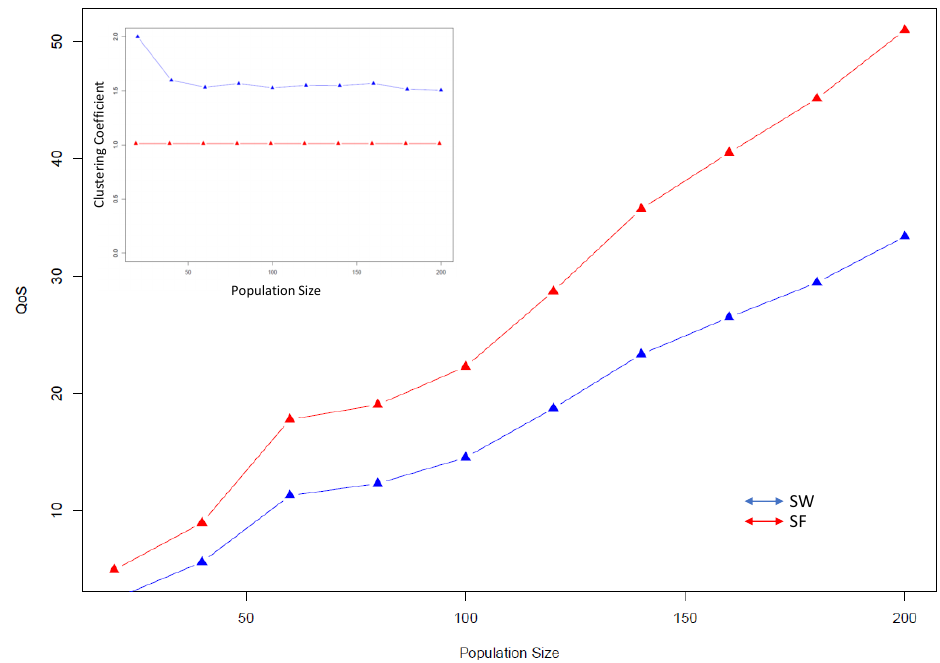
Figure 8. QoS in function of the population size.The figure displays the trend of QoS considering two different structural networks, the scale-free (red line) and the small-world (blue line), assumed as topology for both the microservice and evaluation graphs. The inset shows the clustering coefficient versus the population size in both